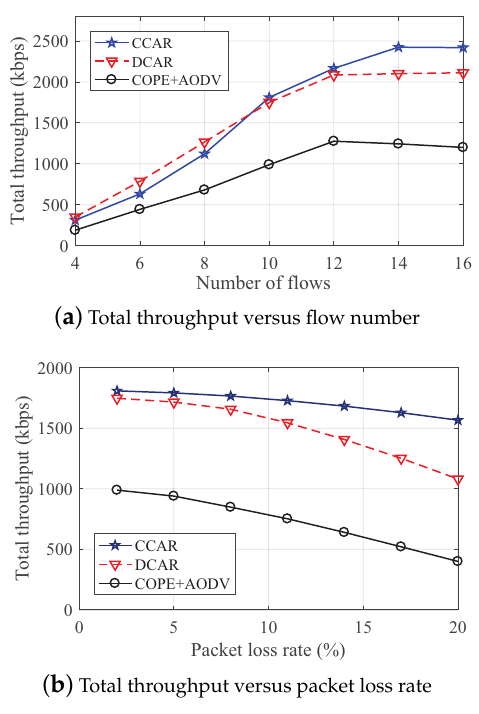
Figure 14. The impact on total throughput in the random